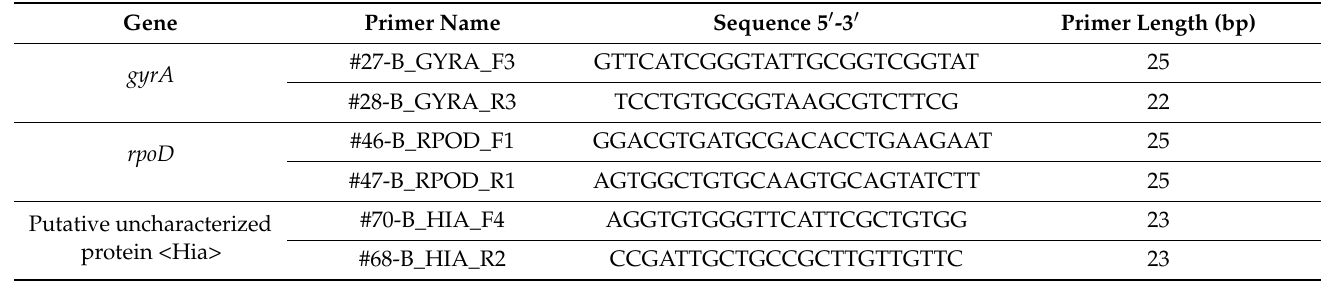
Table 2. Details of primers for reference genes and the target gene used for